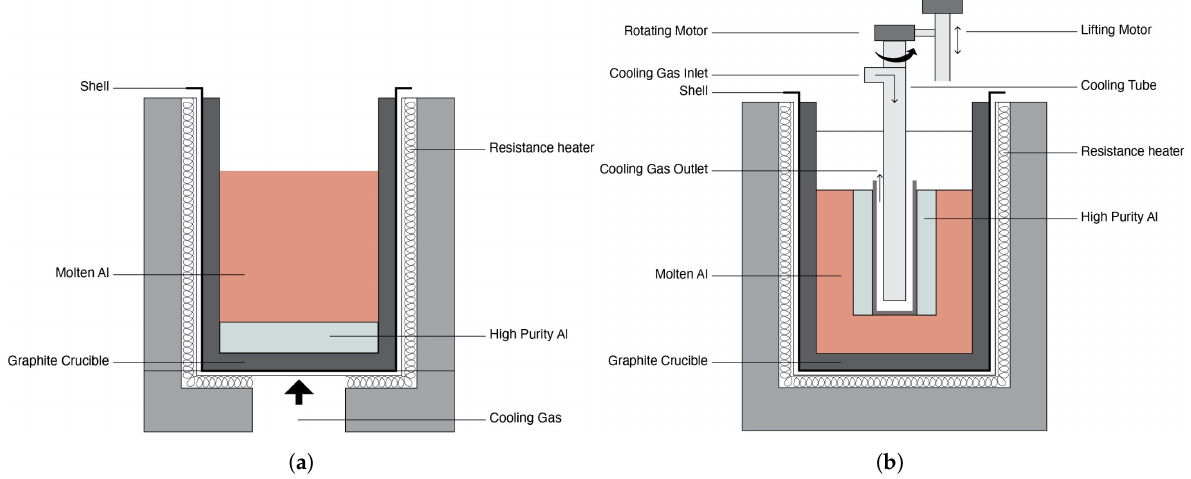
Figure 13. Directional solidification setup ( a ) without forced mixing and ( b ) with forced